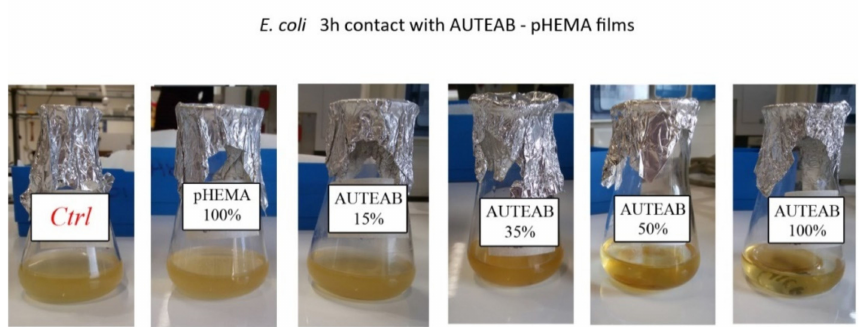
Figure 5. E. coli cultures maintained in contact with AUTEAB-HEMA polymeric films obtained with 15, 35, 50, and 100% AUTEAB. Control (no film exposure) and blank reference (pHEMA) are also shown for